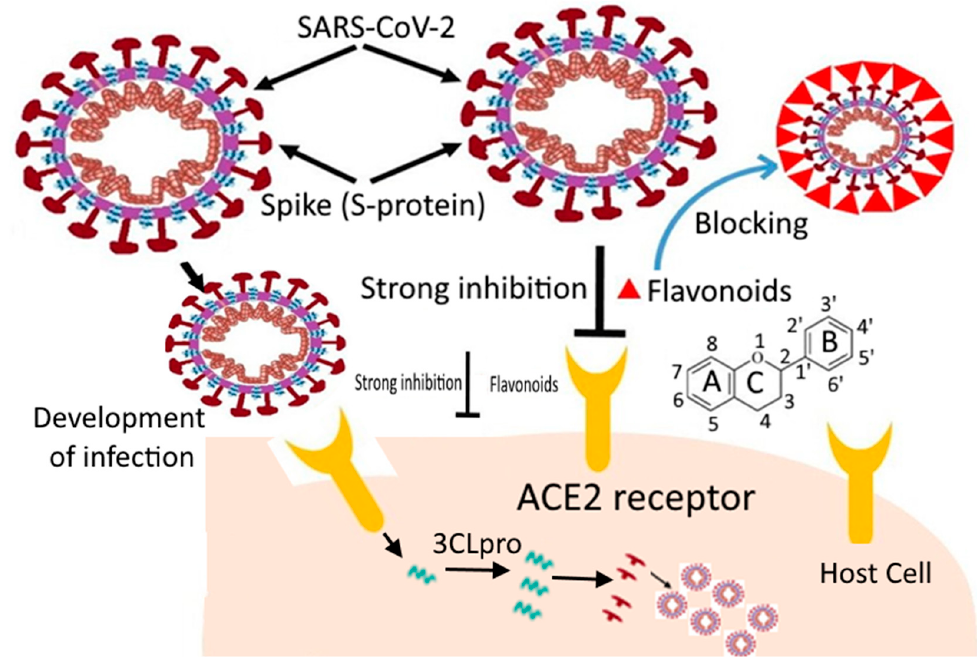
Figure 5. Systematic representation of the mechanism of flavonoid inhibition against SARS-CoV-2. Figure 4 is available under an open-access Creative Commons Attribution License (CC-BY).